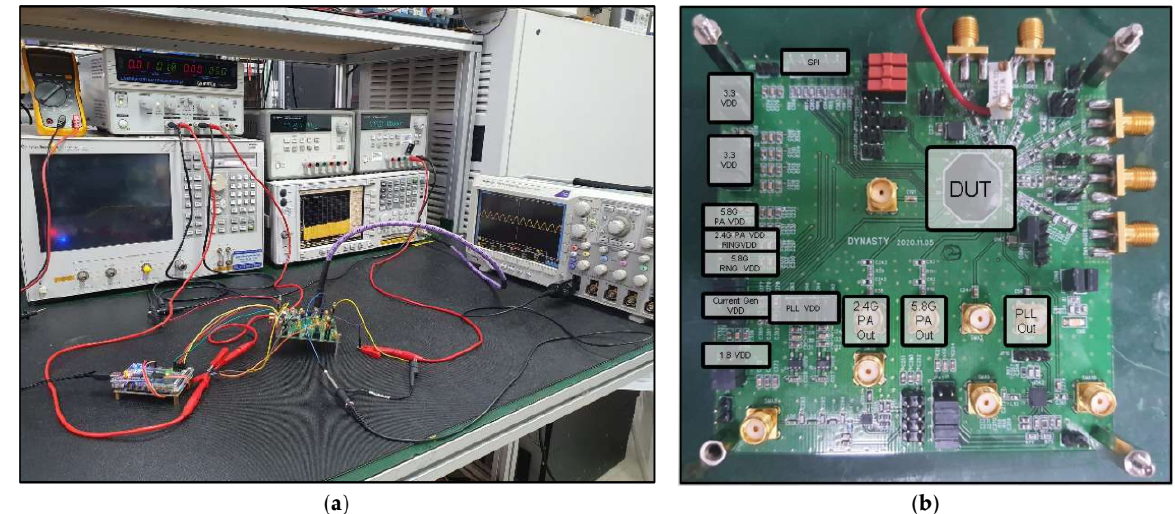
Figure 8. Measurement: ( a ) measurement environment; ( b ) evaluation board.